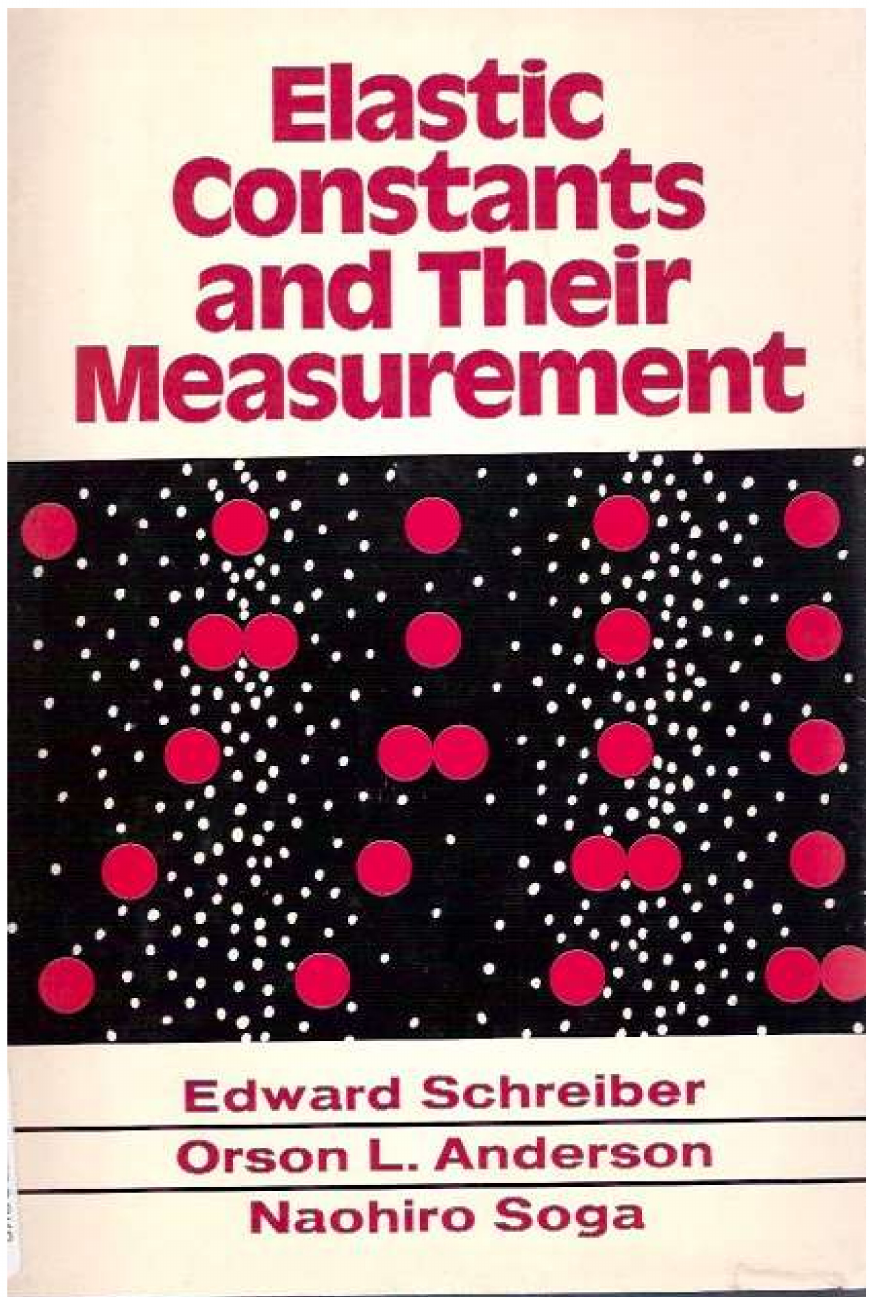
Figure 9. Book by Schreiber, Anderson, and Soga